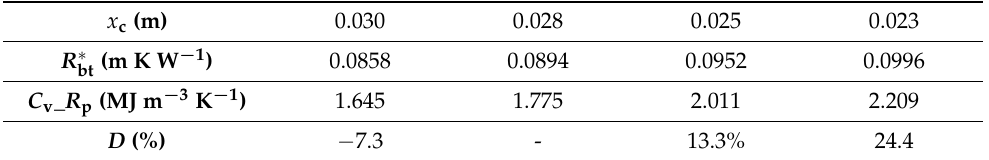
Table 12. Comparison of heat capacity estimates depending on the chosen equivalent borehole thermal resistance. Accuracy of estimation is the same as in Tables 8 and